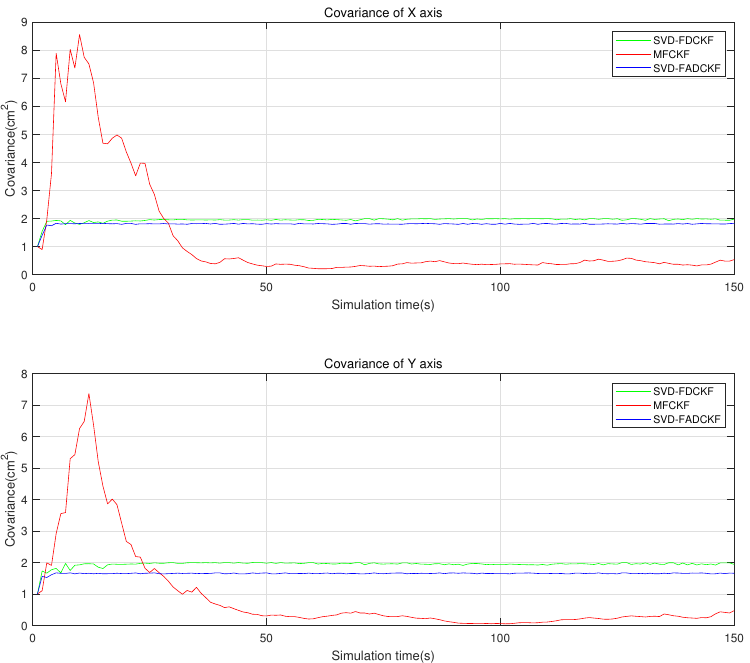
Figure 11. Estimated error covariance in in a selected simulation (3